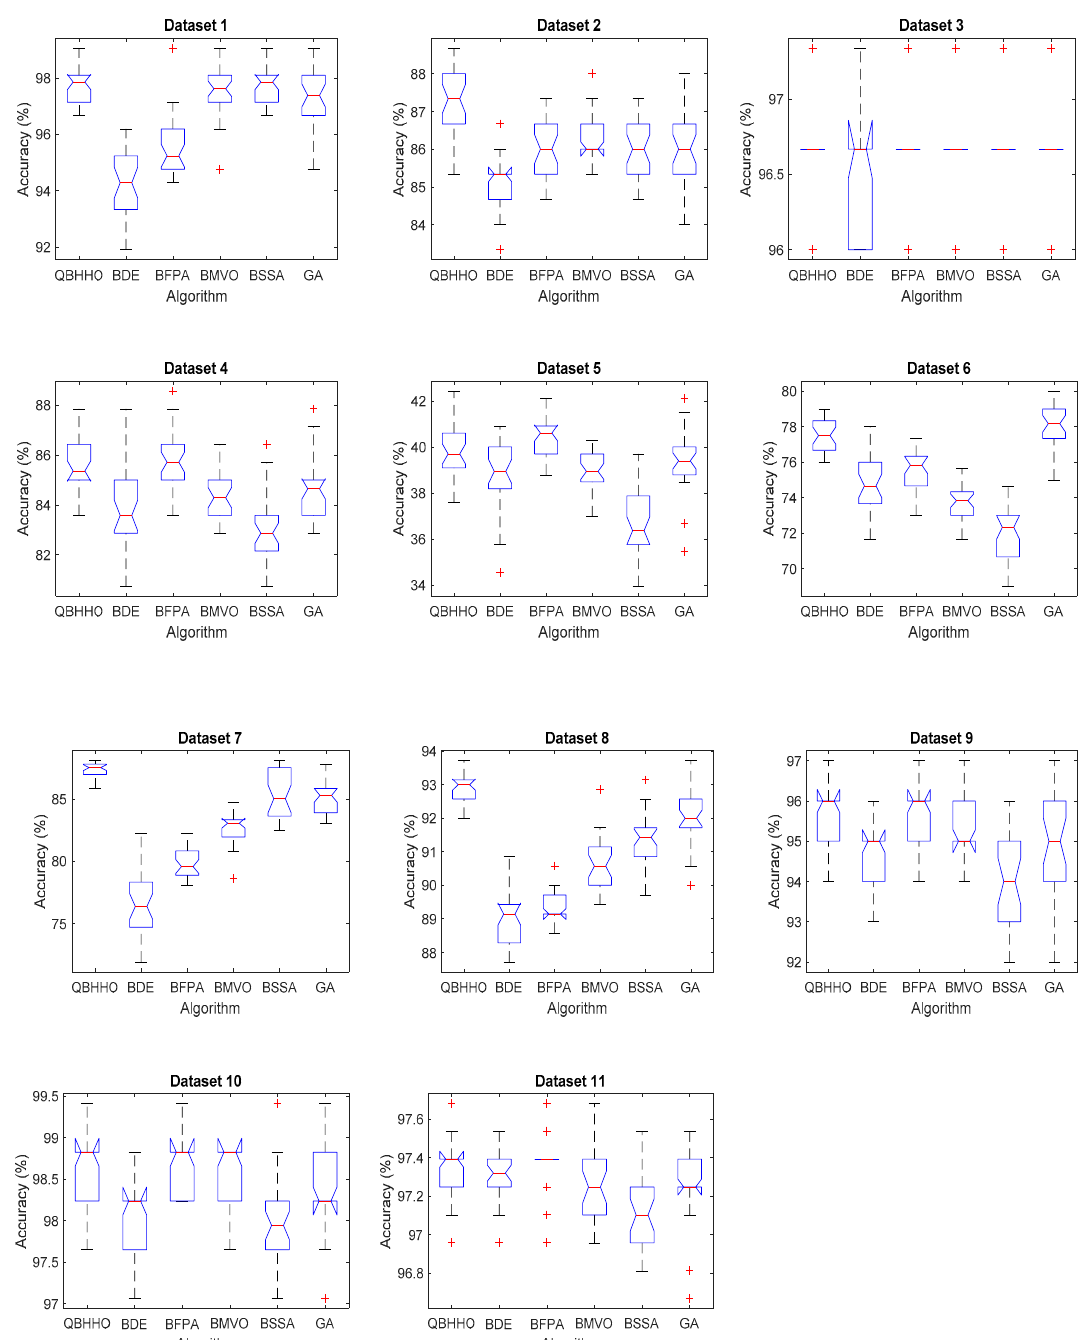
Figure 9. Boxplot of six di ff erent algorithms on datasets 1–11.